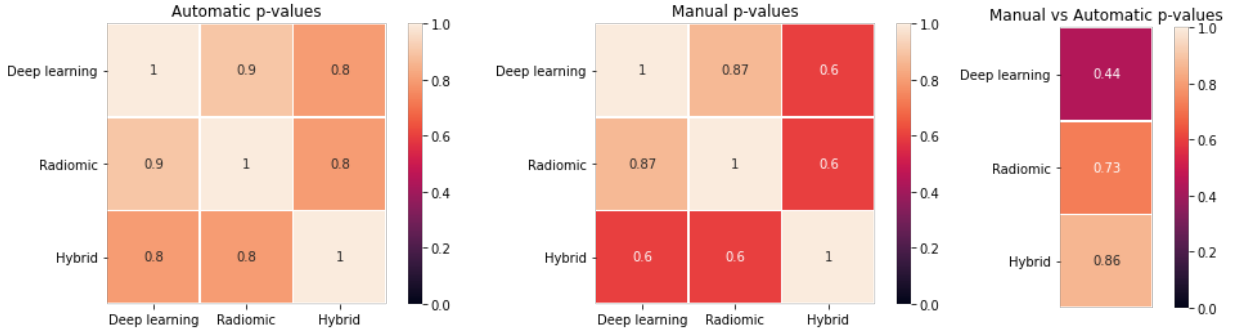
Figure 5 . T -test results of the comparison between the different approaches. ( Left ): p -values for deep-learning versus hand-crafted versus hybrid features for automatic segmentation. ( Centre ): p -values for deep-learning versus hand-crafted versus hybrid features for manual segmentation. ( Right ): p -values for manual versus automatic in case of deep-learning, hand-crafted and hybrid